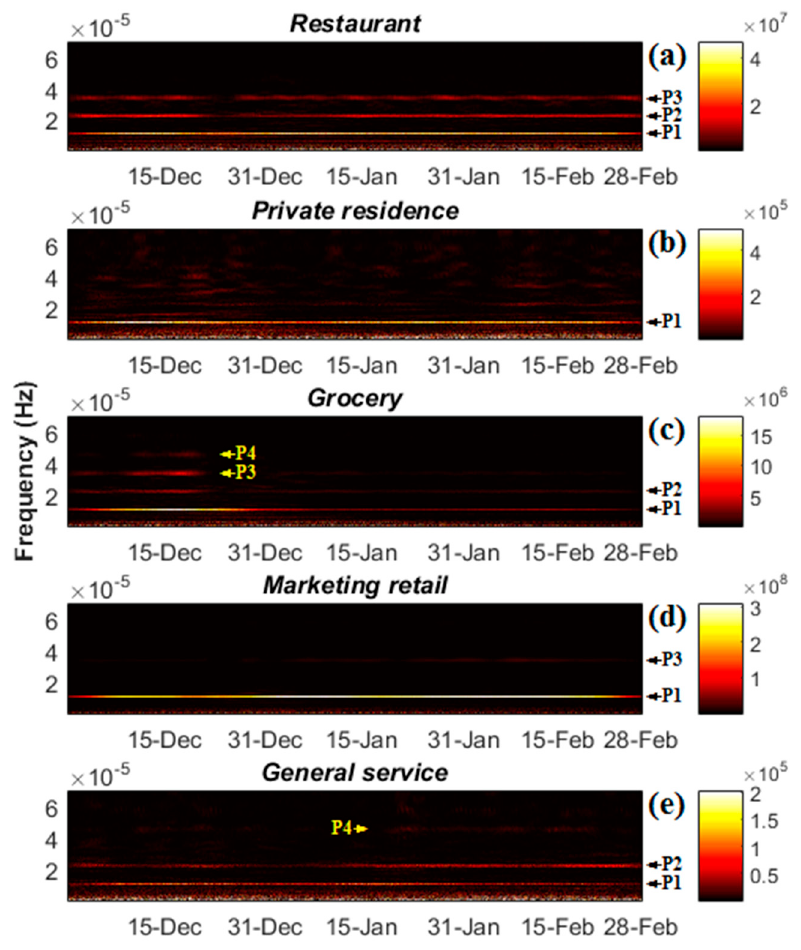
Figure 5. Wavelet scalogram of the active power for ( a ) a restaurant; ( b ) a private residence; ( c ) a grocery; ( d ) a marketing retail establishment; ( e ) a general service.